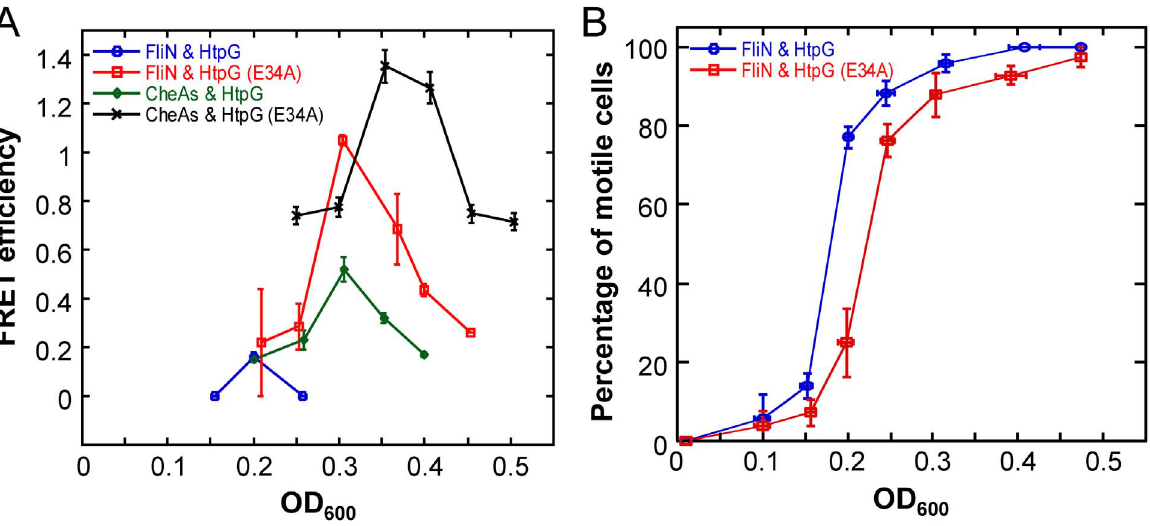
Figure 5. Growth-stage-dependent interaction of HtpG with FliN and CheA. ( A ) Efficiency of FRET between HtpG-YFP or HtpG(E34A)-YFP and FliN-CFP or CFP-CheA as a function of growth stage (indicated by OD 600 value), measured by acceptor photobleaching in wild-type cells (Methods). Error bars indicate standard errors from three replicates. For these assays, a truncated form of CheA lacking the first 97 amino acids (CheA s ) was used because this fusion was more stable against spontaneous proteolysis than the fusion to full-length CheA, but showed similar interaction with HtpG (Table S4) ( B ) Growth-stage dependence of motility in cultures used for FRET measurements in (A), assayed as a percentage of motile cells The onset of cell motility is substantially delayed in cells expressing HtpG(E34A). Error bars indicate standard errors from three replicates.